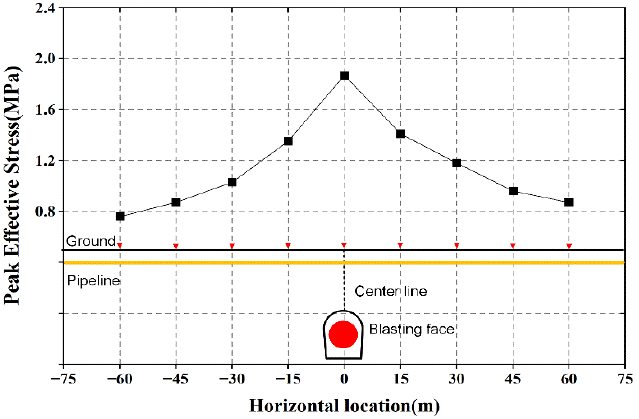
Figure 11. Distribution of PES on the pipeline.